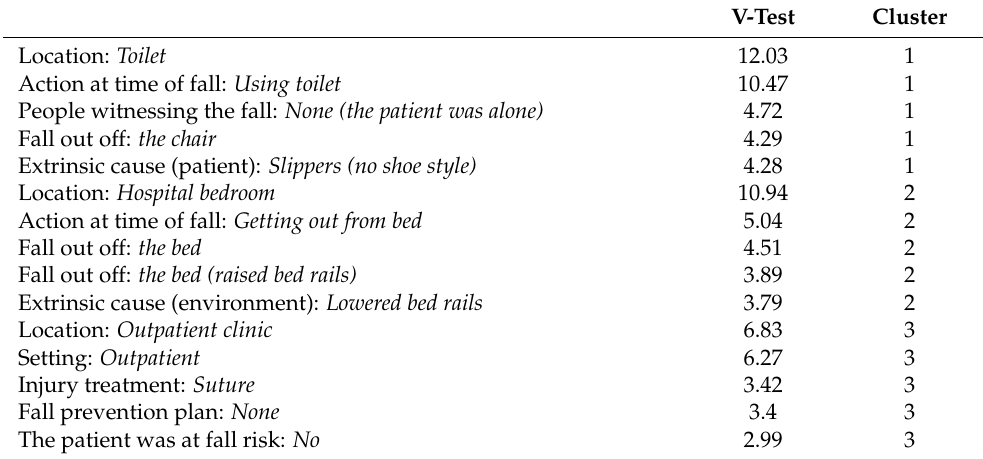
Table 3. Results of the HCPC analysis without topic variable. V-test represents the influence of variables in the cluster composition. Cluster refers to the three distinct profiles of falls obtained from the HCPC